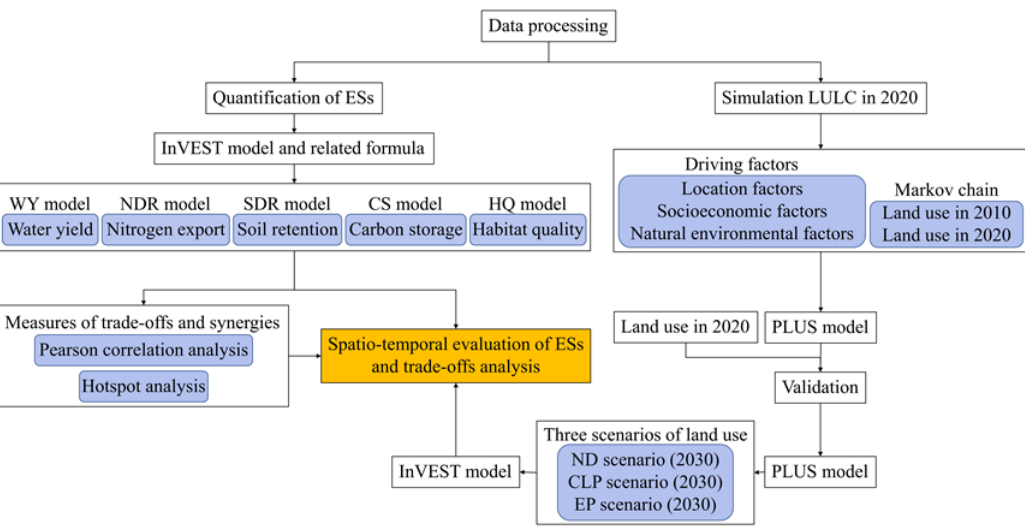
Figure 2. The research framework used in this